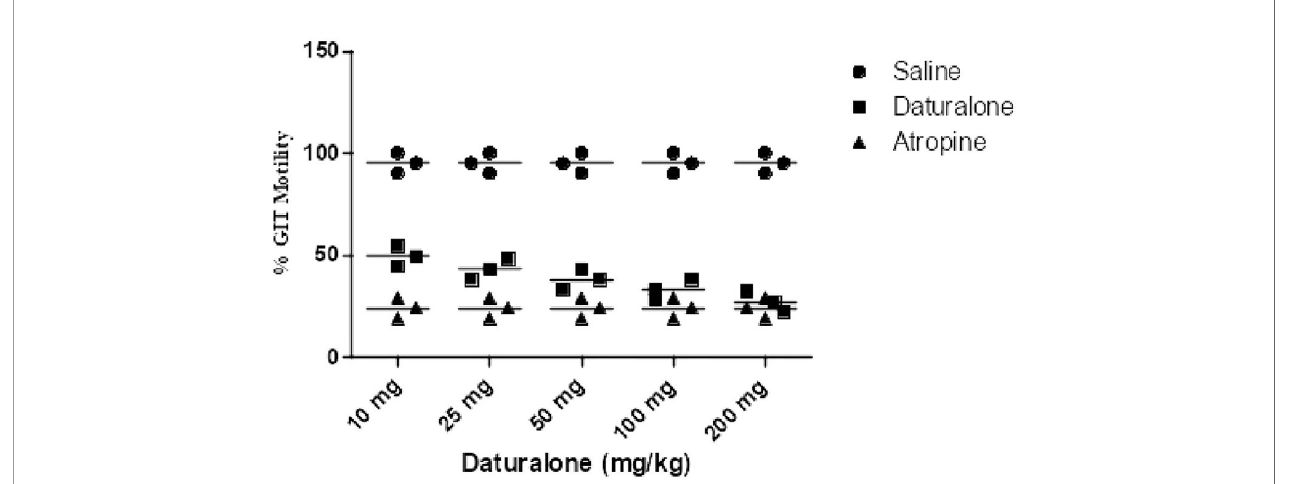
FIGURE 3 | Bar diagram indicated the GIT motility screening pro fi le of daturalone ( 1 ) in dose-dependent method of charcoal meals through the small intestine of mice.